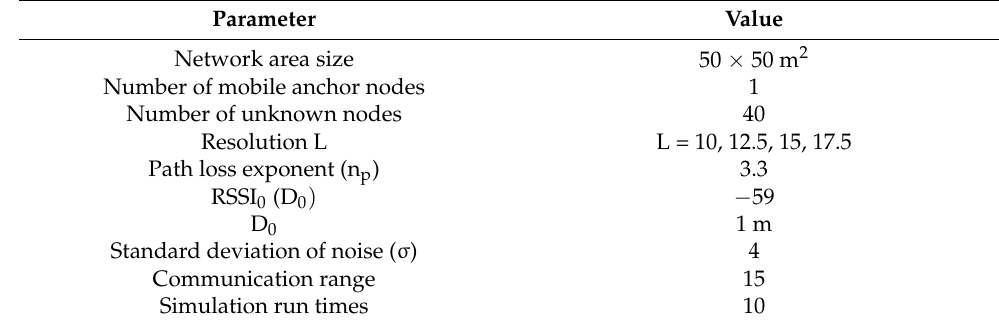
Table 1. Experimental Parameters.